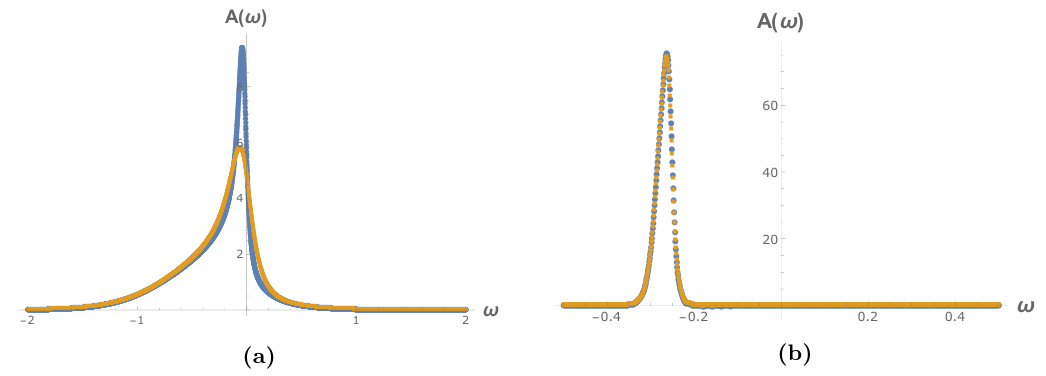
Figure 9. (a) The spectral function of the initial state(blue) and the final state(orange) in the liquid phase. (b) The spectral function of the initial state(blue) and the final state(orange) in the dilute gas